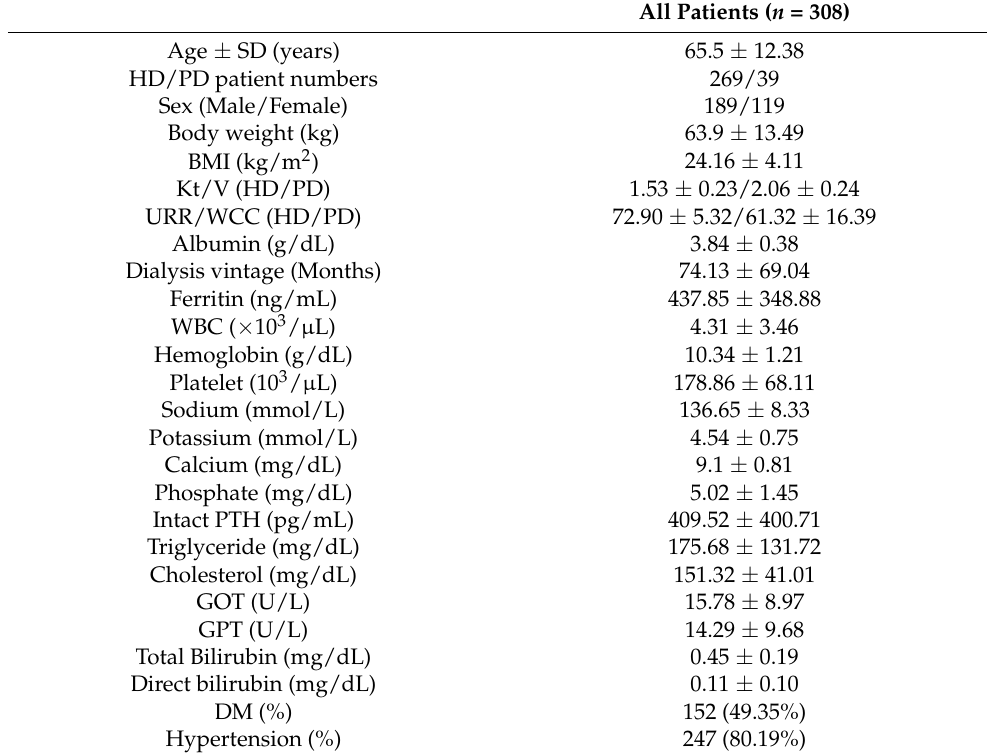
Table 1. Demographic, clinical, and laboratory data of chronic dialysis